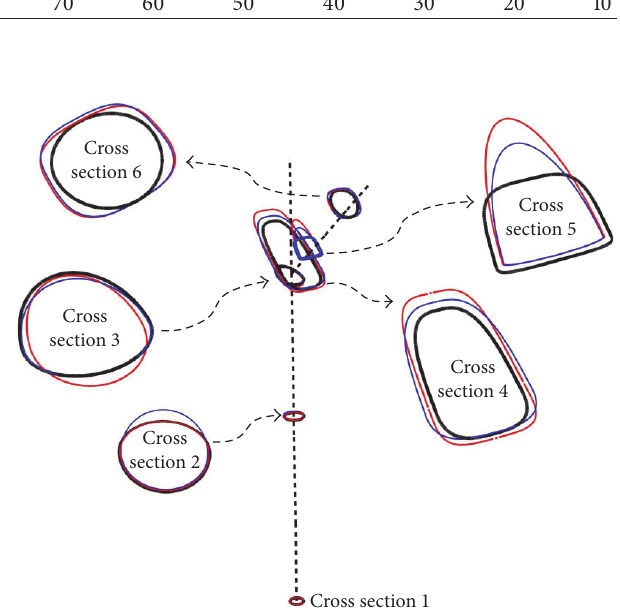
Figure 16: Change in the size and profile of the cross sections for all of FGM-1 (black), FGM-2 (red), and FGM-3 (blue) configurations.